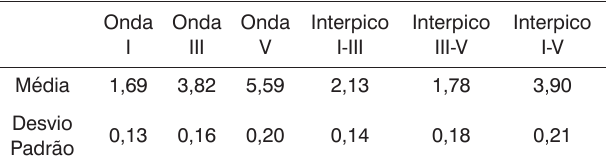
Tabela 1. Médias e desvios padrão (ms) das latências absolutas e intervalos interpicos dos PEATE de adultos normo-ouvintes, segundo Esteves et al. (2009) 21